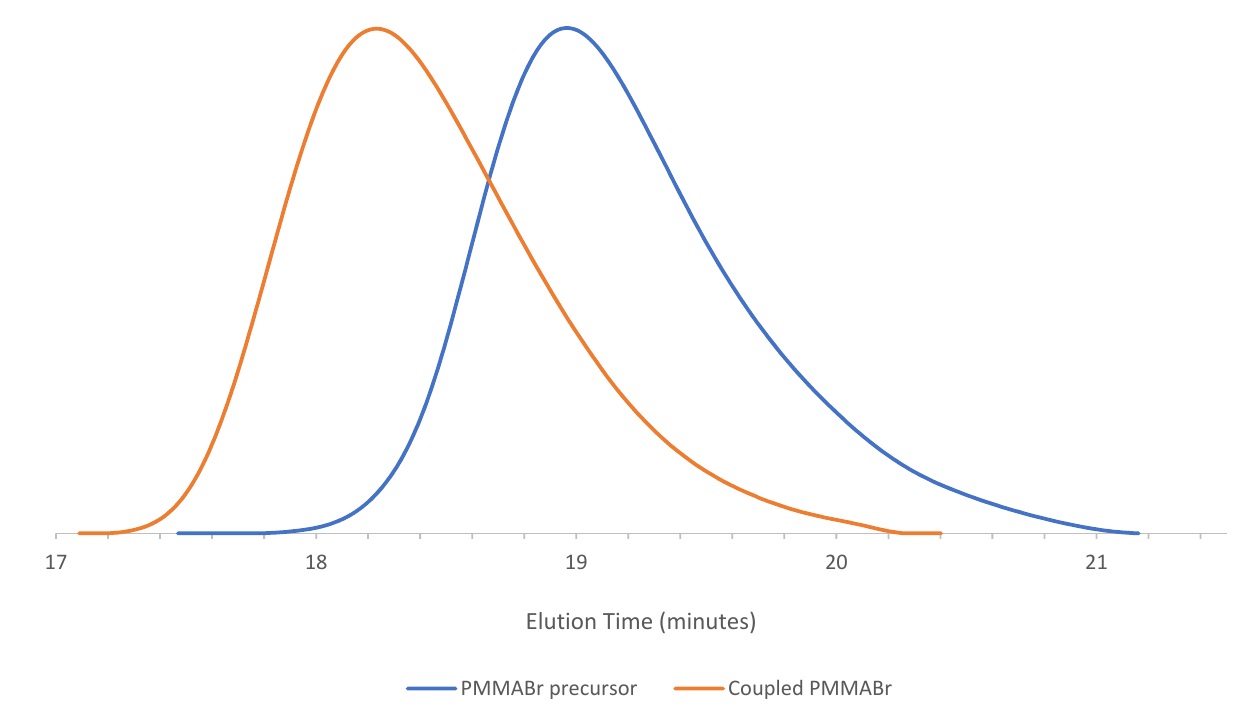
Figure 3. GPC traces of PMMABr precursor (blue) and RTA-ATRC product (orange) under universal conditions using nitrosobenzene as the radical trap-assist. Traces correspond to Table 2, Trial 16. Table 3. Characteristics of PSBr precursors and results of their RTA-ATRC